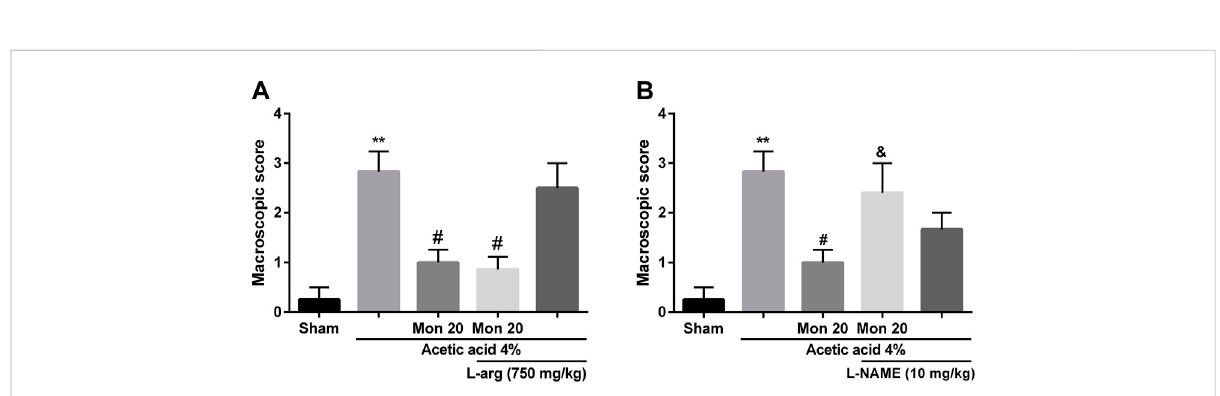
FIGURE 2 EvaluationoftheinvolvementoftheNOintheprotectiveeffectofmontelukast(Mon,20 mg/kg)onthemacroscopicscoreofcolontissue.The effect of pre-treatment with L-arginine (L-arg, 750 mg/kg, (I) p.) and L-NAME (10 mg/kg, (I) p.) on the effect of Mon is shown in panels (A) and (B) , respectively. The results are expressed as the means ± SEM of six rats per group. ** p < 0.01, when compared to the Sham group; # p < 0.05 when compared to the acetic acid group; & p < 0.05, when compared to the Mon-treated group. The statistical analysis was performed by ANOVA followed by Tukey ’ s post hoc